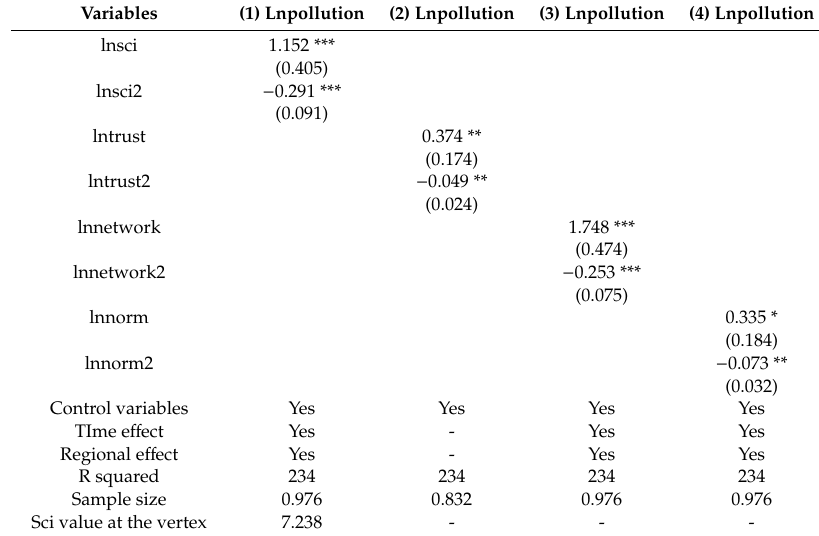
Table 6. Regression results after deleting municipality.